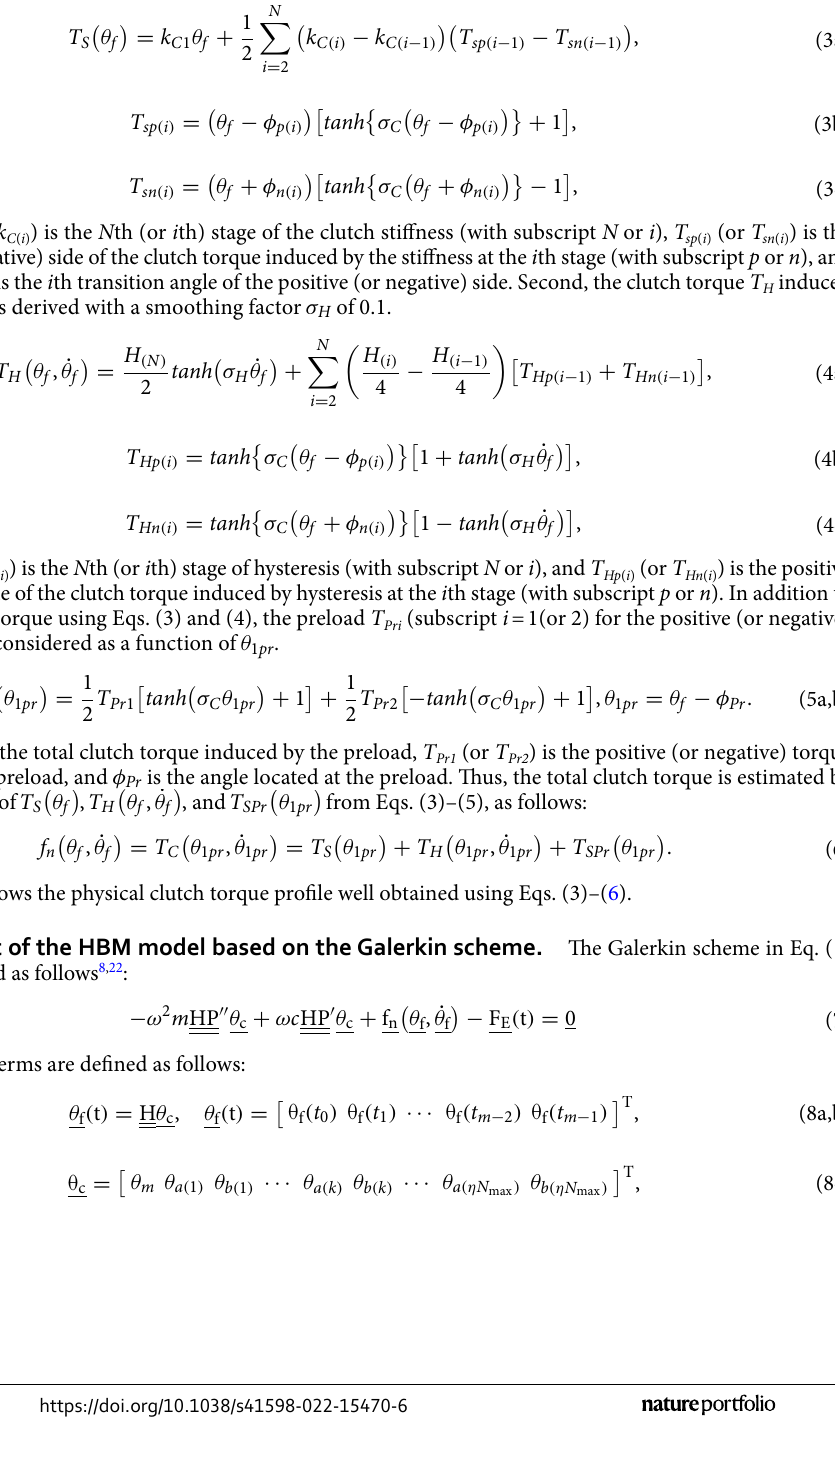
from the stiffness with a smoothing